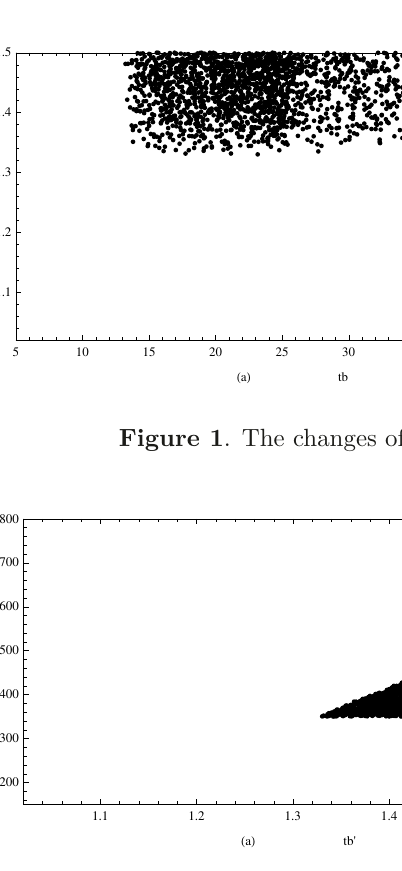
Figure 2 . The second light Higgs boson masses change with the parameters tb ′ and B η